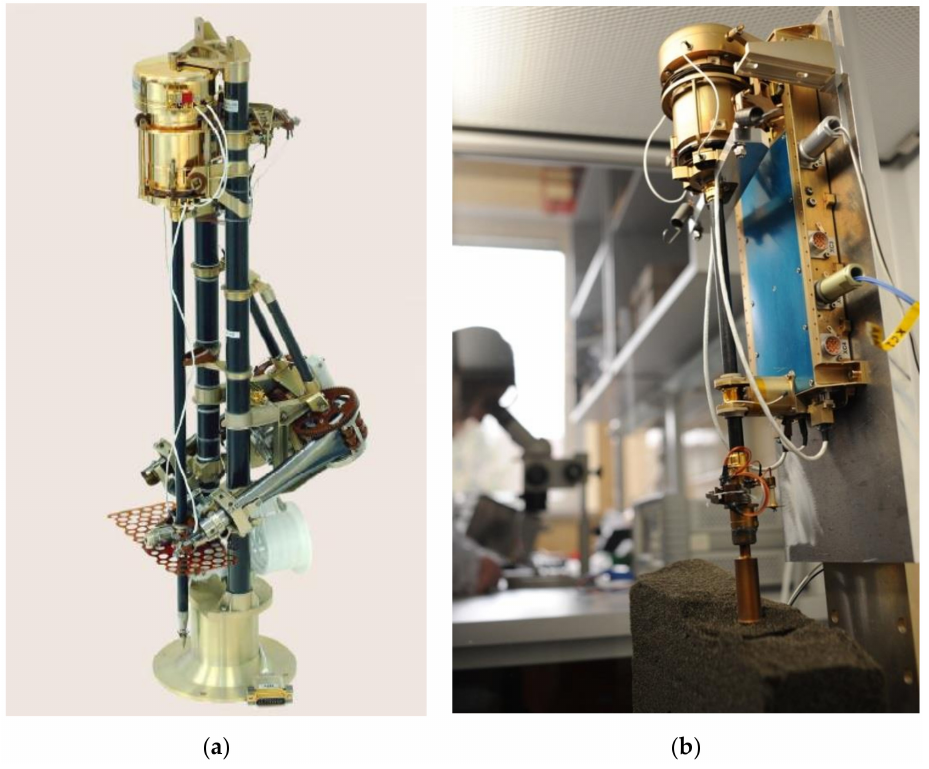
Figure 3. MUPUS ( a ) and CHOMIK ( b ) penetrators